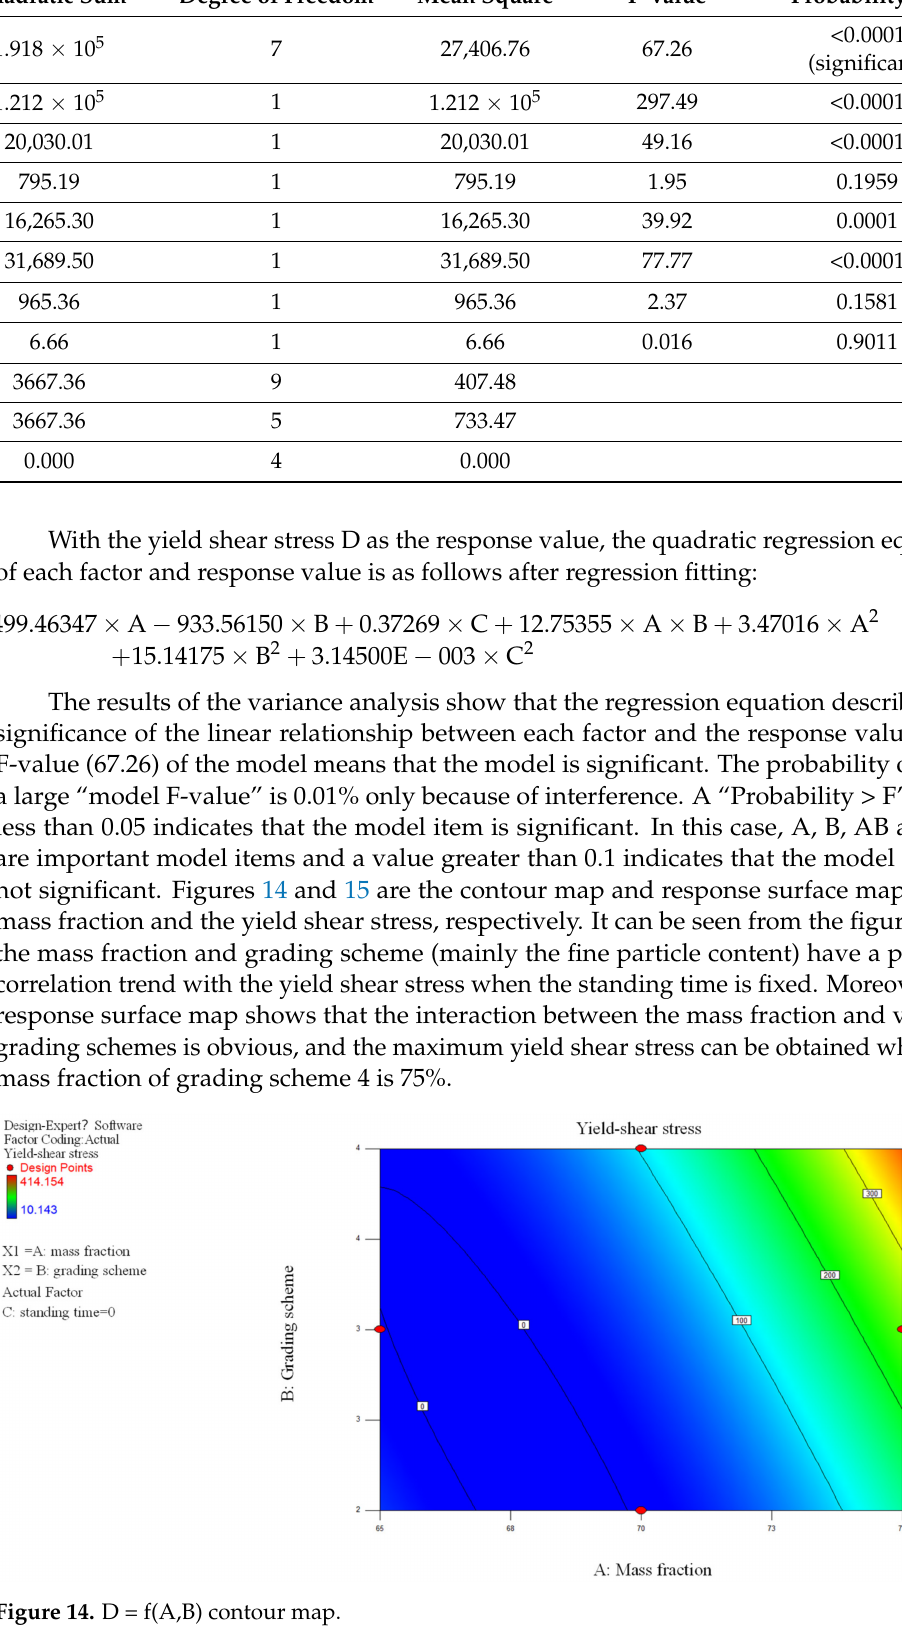
Figure 14. D = f(A,B) contour